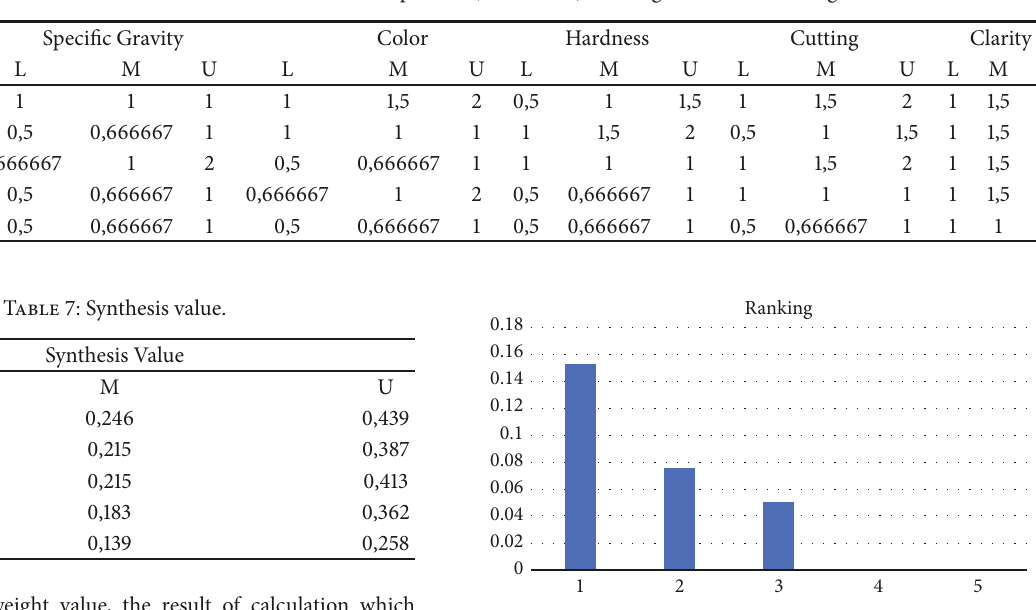
Table 6: TFN set of criteria; each value in the criteria comparison (see Table 2) is changed to TFN referring to the TFN scale.